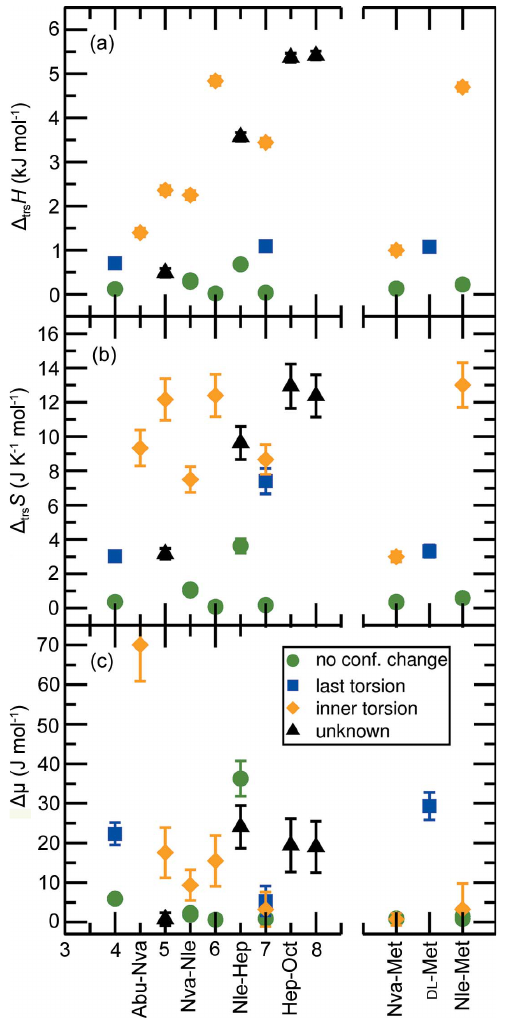
Figure 6 Characteristics of the solid-state phase transitions of linear-chain racemic and quasi-racemic amino acids; ( a ) transition enthalpies, ( b ) transition entropies and ( c ) transition Gibbs free energy [driving force, equation (3)] versus the number of carbon atoms per